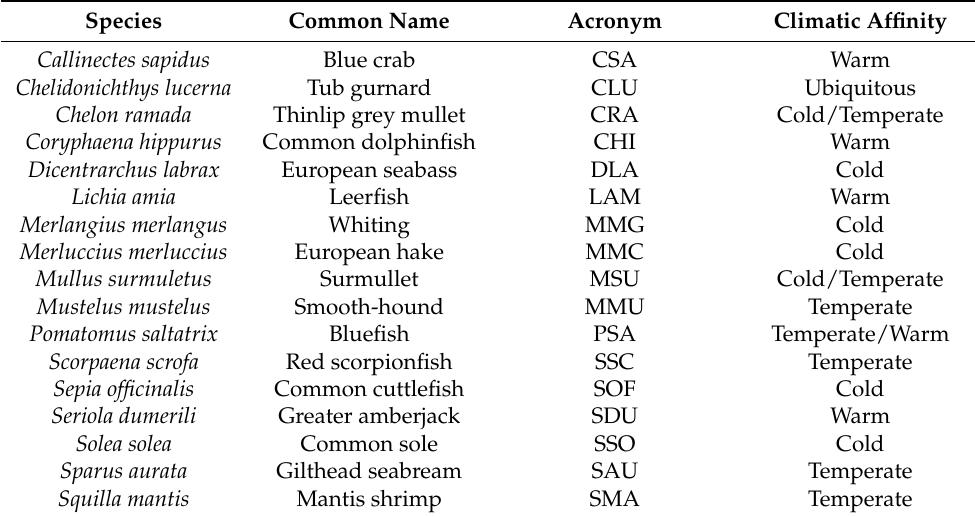
Table 1. The 17 species targeted by SSF considered in the present study, with their climatic affinity (see text for further